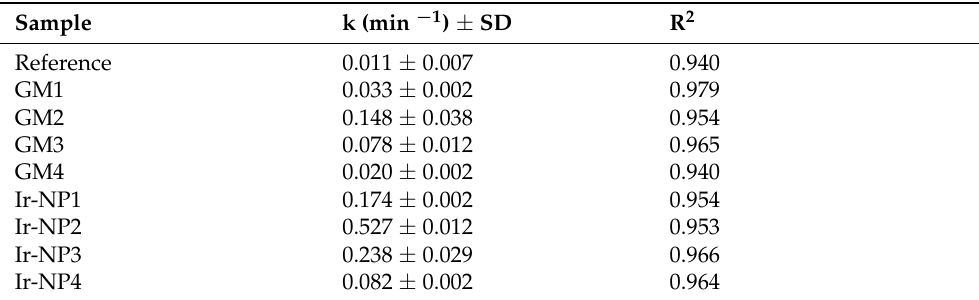
Figure 8. Constant rates (k) comparison between Ir-NPs, reference, and extracts.